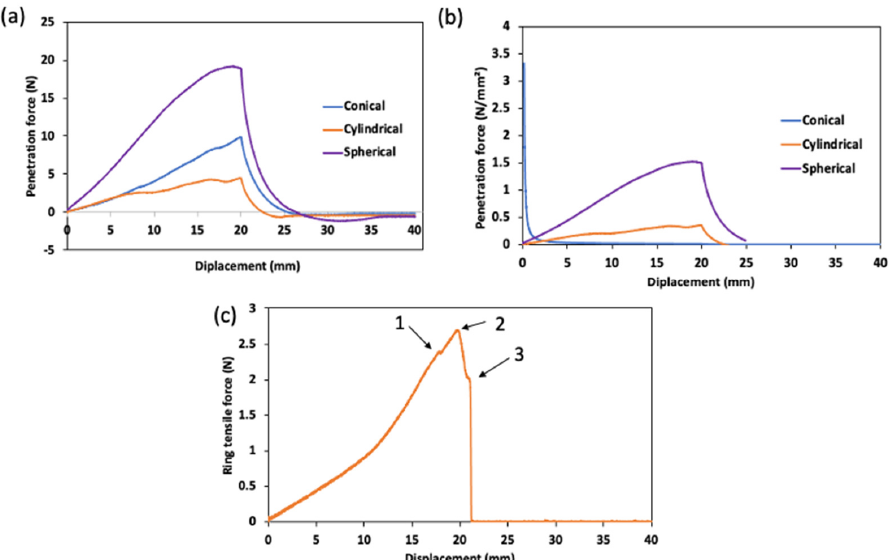
Figure 1. Mechanical properties of surimi gel; ( a ) Force-time curve from the penetration test, ( b ) Normal- ized penetration force per unit area, and ( c ) Force-time curve from ring tensile until the failure.